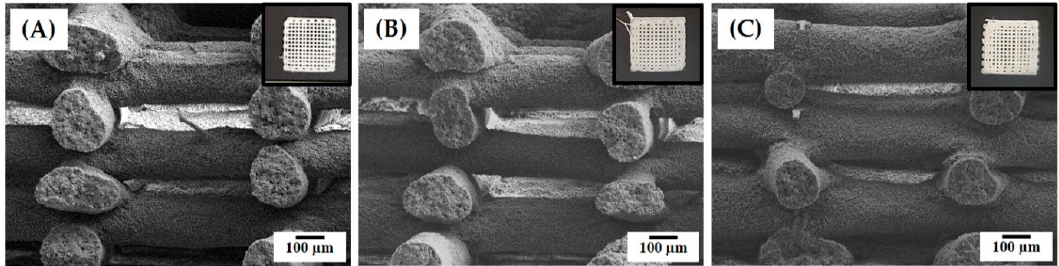
Figure 6. Representative FE-SEM images of the hierarchical macro/micro-porous porous PCL–CaP composite scaffolds produced using different CaP contents: ( A ) 0, ( B ) 10, and ( C ) 20 wt%. Insets in